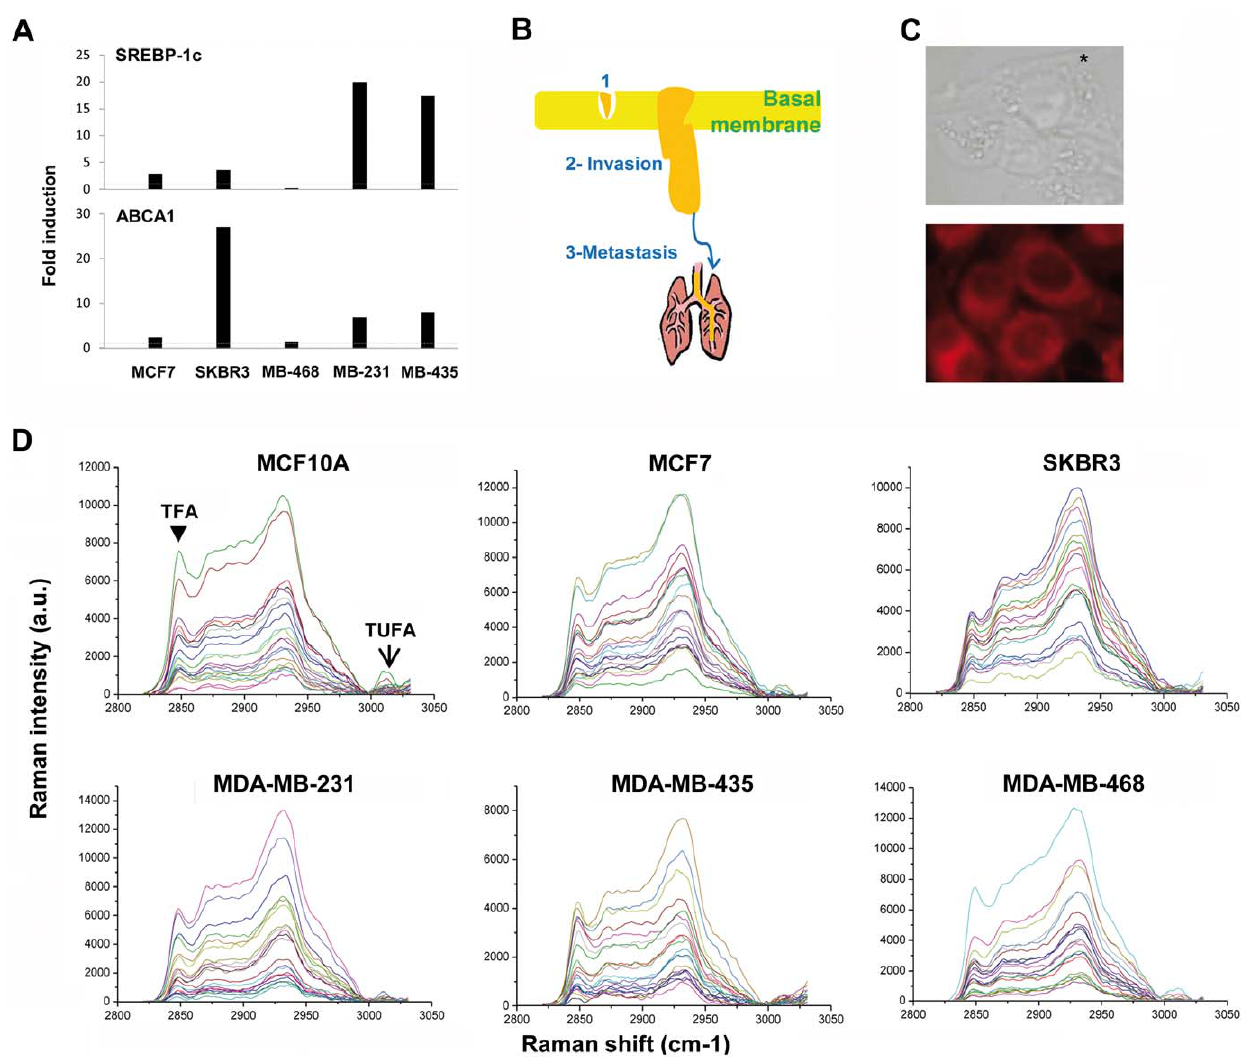
Figure 1. Variability in lipid metabolic genes expression and FA composition in MDA-MB-231, MDA-MB-435, MDA-MB-468, MCF7 and SKBR3 cell lines analysed by Raman microspectroscopy. A) The gene expression of SREBP-1c and ABCA1 were examined after 24 h treatment with the LXR agonist T0901317 2 m M compared to the basal conditions by RT and real-time PCR. The fold induction is represented over the pointed line. Cyclophilin A gene was used for normalization. B) Simplistic representation of the progression status of breast cancer cells used in the study: 1) MCF10A cells; 2) MCF7, SKBR3 and MDA-MB-468 and 3) MDA-MB-231 and MDA-MB-345. C) Above, brightfield image of MDA-MB-435 cells, with an asterisk indicating the position of the measurements in the cytoplasm. 60 6 magnification and 9 mW power were used. Down, fluorescence microscopy image of MDA-MB-435 cells stained with Nile red. 40 6 magnification was used. D) Measured raw Raman spectra of the cell lines where the axes are intensity (in arbitrary units) versus Raman shift (cm 2 1 ). MCF10A cells were also measured. The TFA (2845 cm 2 1 ) and TUFA (3015 cm 2 1 ) bands are indicated with the arrows in the first spectra.